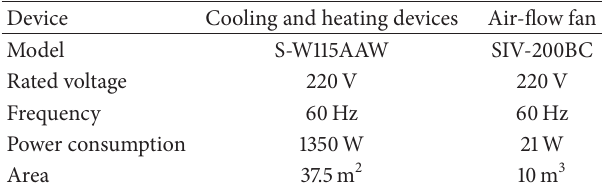
Table 1: Specifications of the cooling/heating devices and air-flow